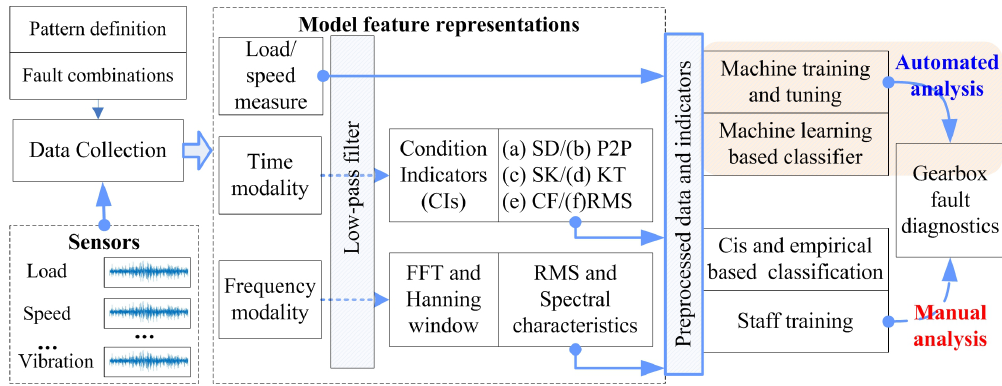
Figure 1. Comparison of the basic fault diagnostics